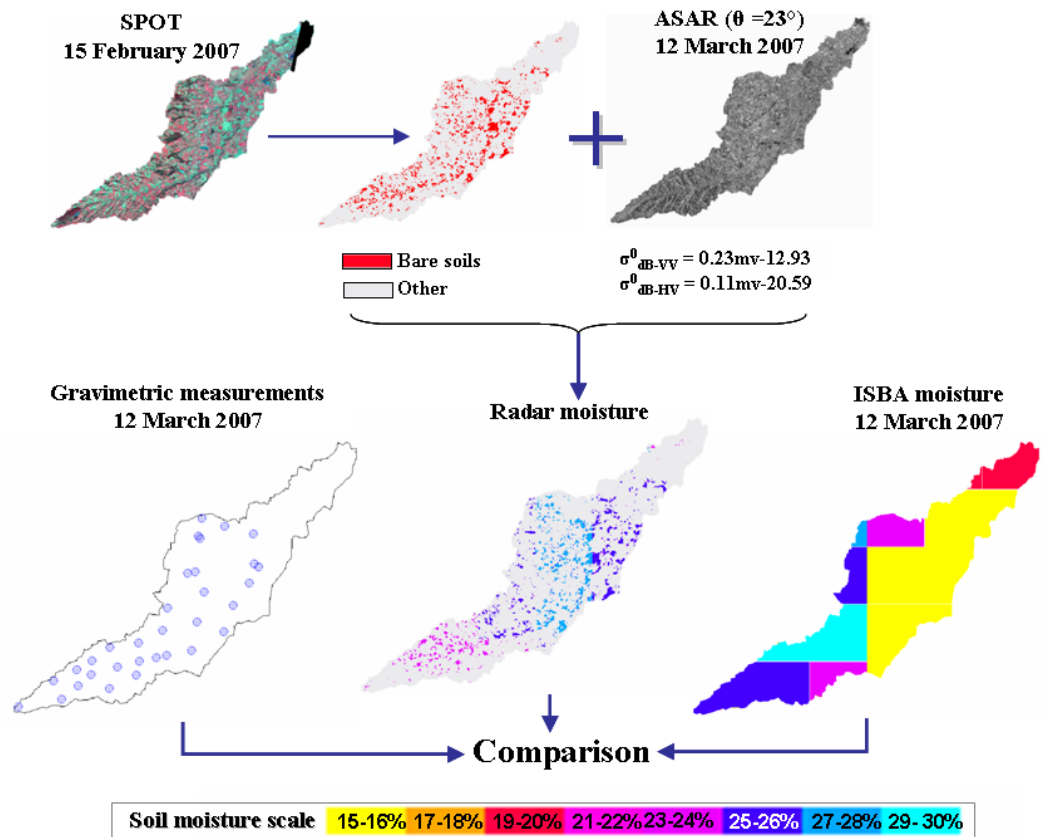
Figure 5. Procedure for mapping soil moisture from SAR images. Optical images are used for bare soils mapping. Radar soil moisture is estimated only over bare soils. The class denominated “other” includes forests, soils covered with vegetation, etc. For the date of March 12, 2007 a comparison between radar soil moisture, in situ soil moisture measurements (gravimetric measurements), and ISBA simulations is